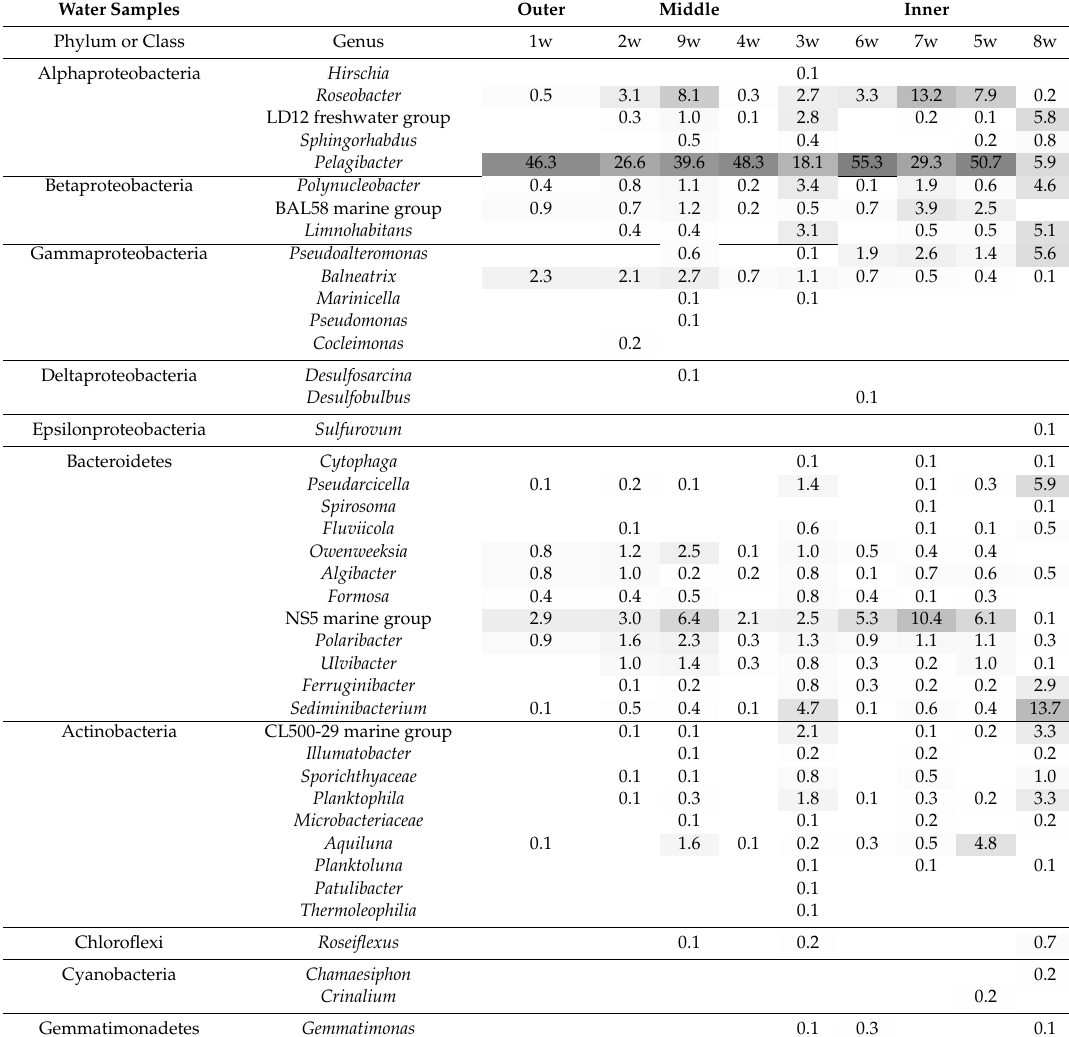
Table 3. Bacterial genera retrieved in water and sediment samples along the Pasvik River. Phyla occurring at percentages below 0.1% at all stations are not reported. Water Samples Outer Middle